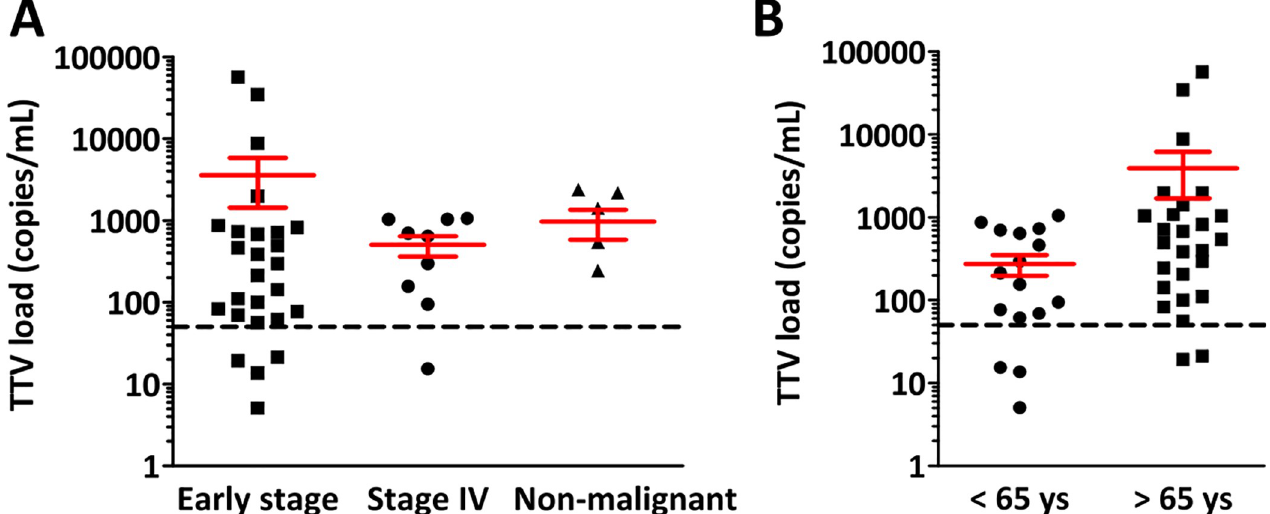
Fig 1. Baseline TTV DNA levels. (A) There was no significant difference in the TTV copy numbers in the blood of arly stage and stage IV lung cancer patients and patients without malignant lung tumors. (B) Patients older than 65 years of age had significantly lower TTV DNA levels in the blood (p = 0.022).